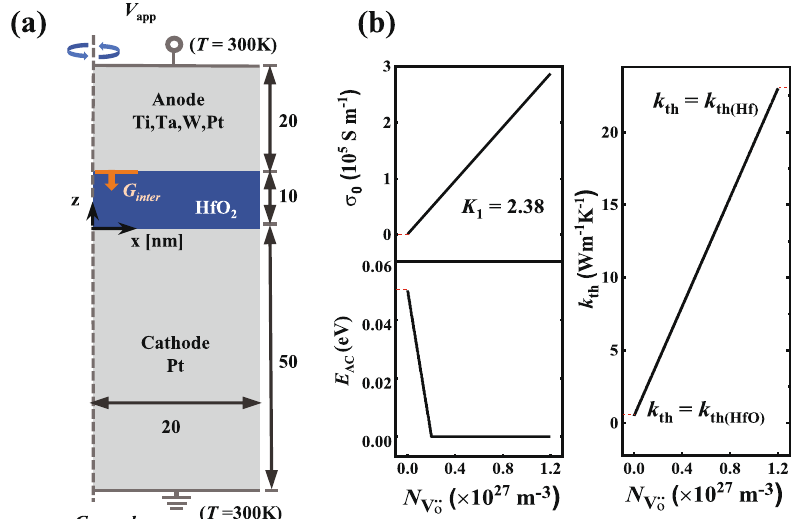
Fig. 6 Model geometry and Simulation parameters. a Model size and geometry. Voltage is applied at the top electrode (anode) and the bottom electrode (cathode) is grounded. Oxygen exchange is assumed to take place at the interface between anode and oxide in a con fi ned region ( x = 0 – 5, z = 10 nm). b Electrical conductivity preexponential factor σ 0, activation energy for conduction E AC, thermal conductivity k th as 38,56 a function of local oxygen vacancy density N V :: o